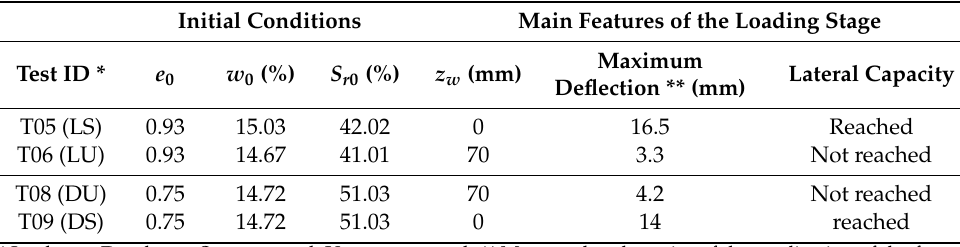
Table 2. Initial conditions and main features of the centrifuge tests (after [11]).